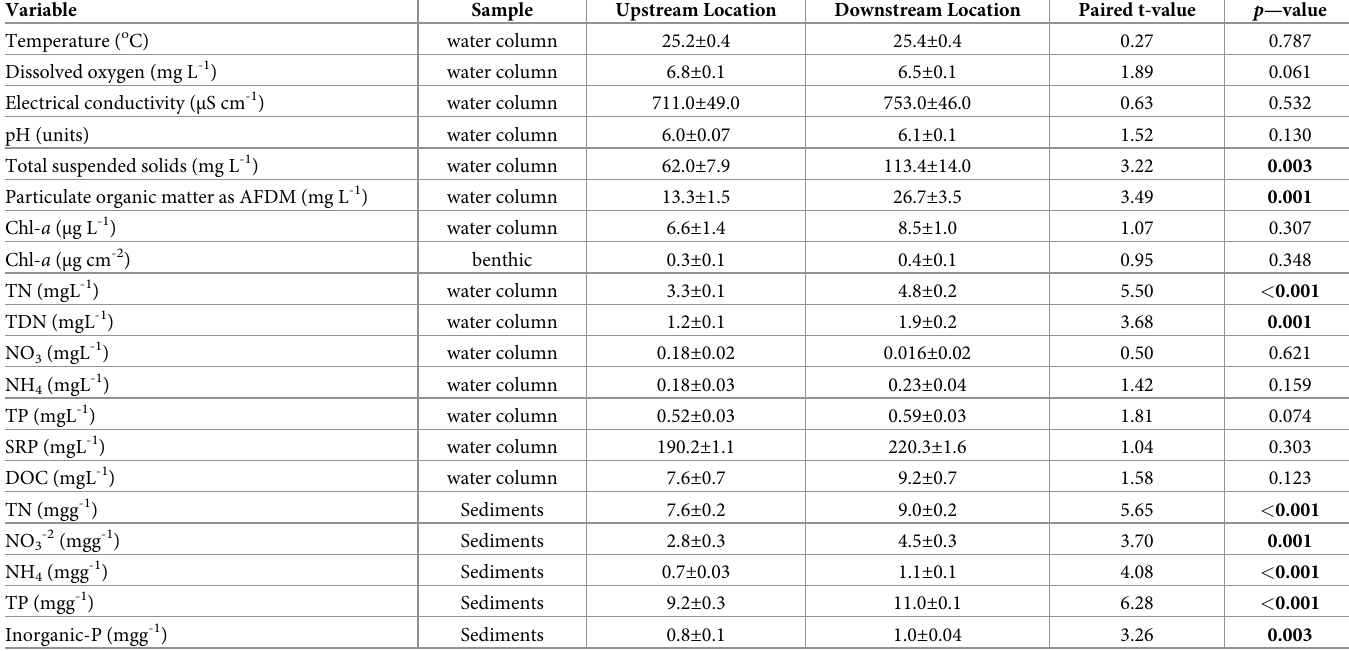
Table 6. Mean ( ± SD) variation in water quality variables and nutrient concentrations in the water column and sediments at the upstream and downstream river reaches of livestock watering sites in the Talek River, a tributary of the Mara